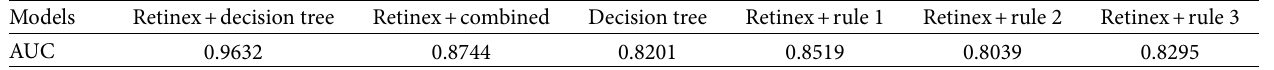
Table 1: Area under curve (AUC) for multiple crash detection